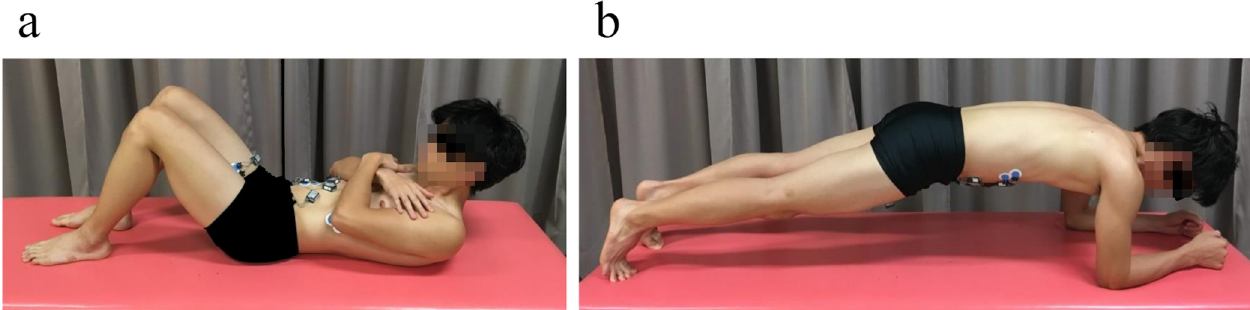
Fig 1. Traditional core stabilization exercise from lateral view. a) Abdominal Crunch, b)